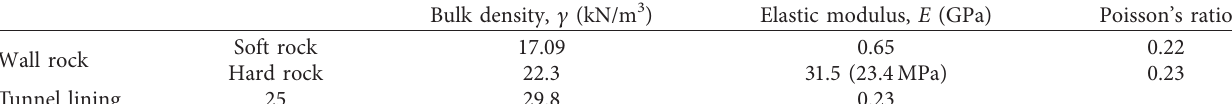
Table 1: Mechanical parameters of lining and rock materials.